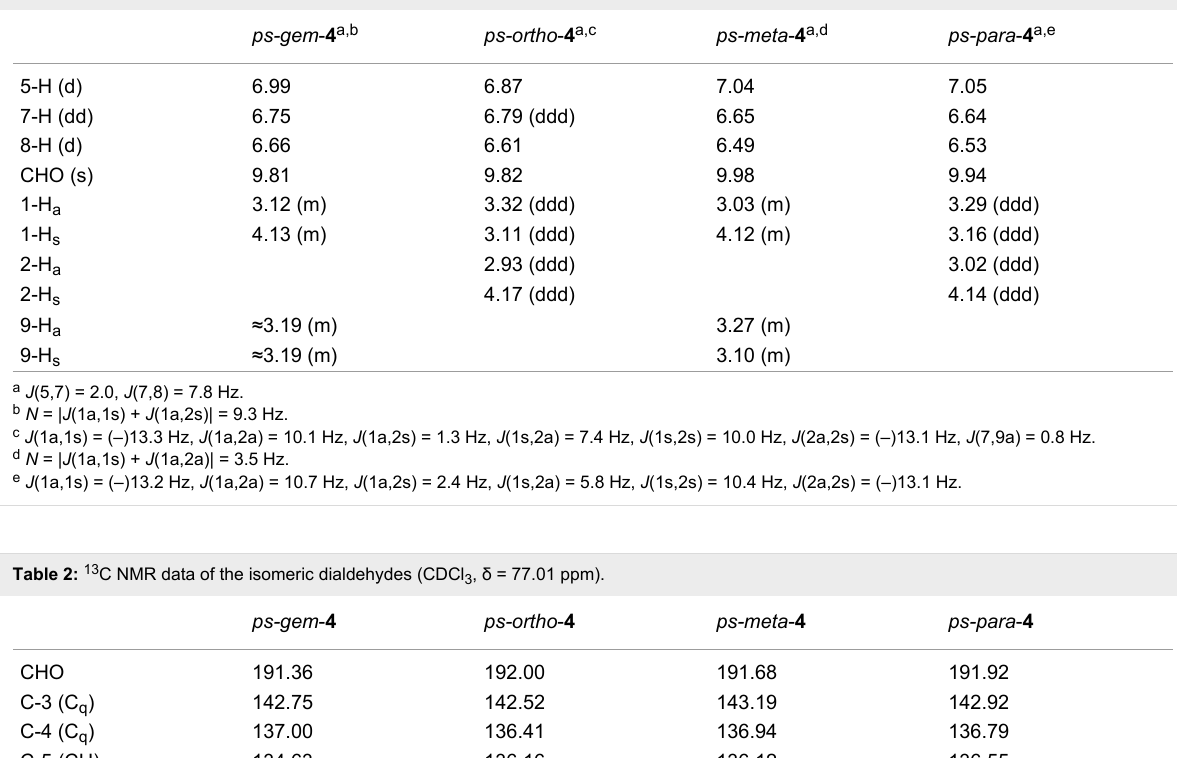
Table 1: 1 H NMR data of the isomeric dialdehydes (CDCl 3 /TMS).